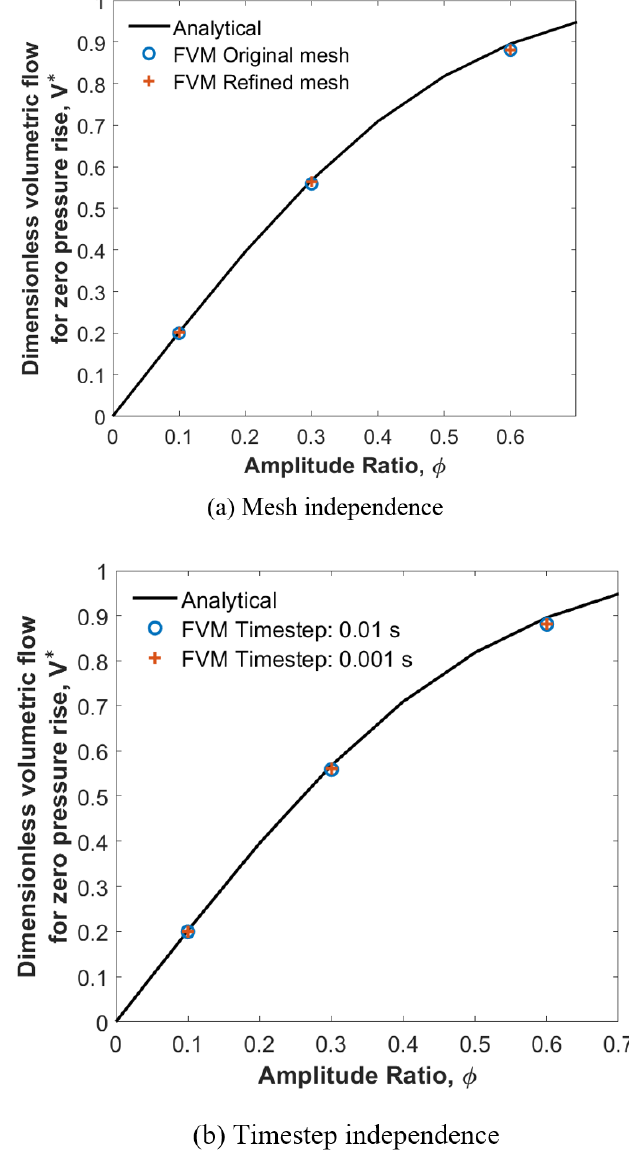
Figure 18. Mesh and timestep independence studies on the FVM